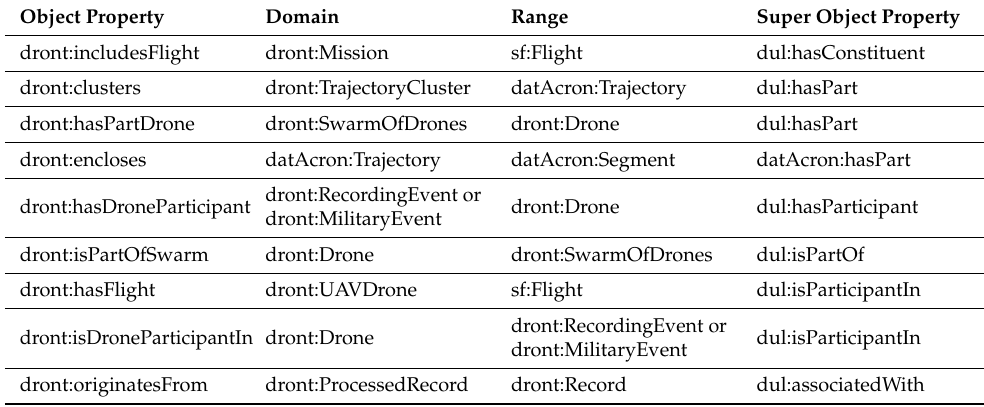
Table 2. Key properties of the Onto4drone